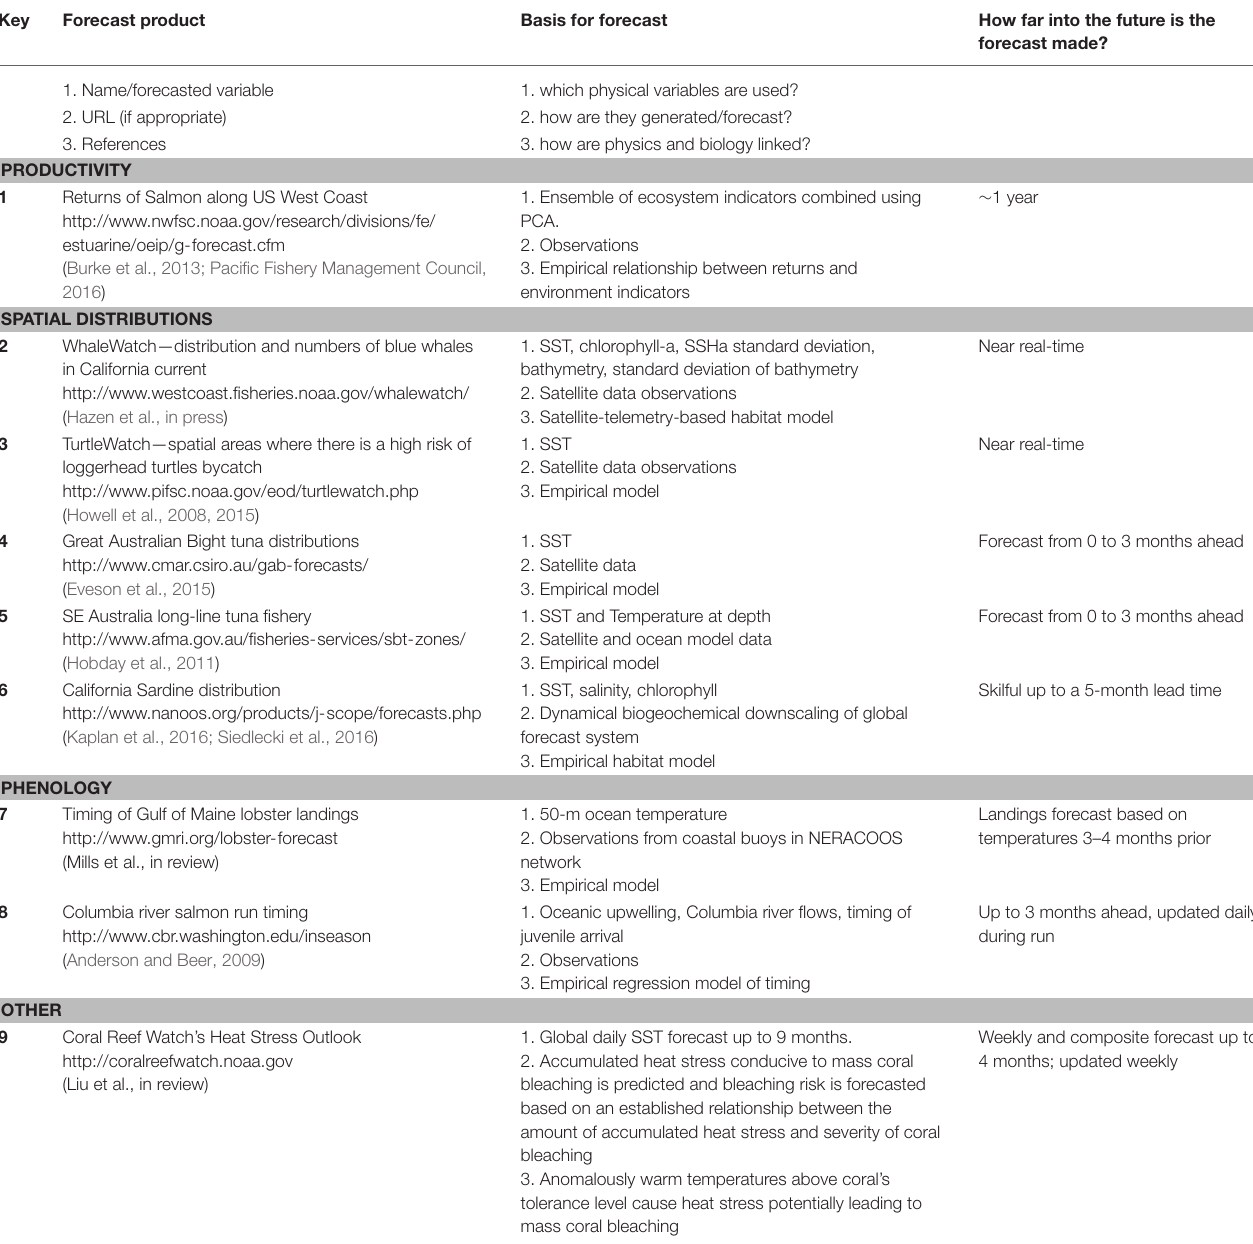
TABLE 1 | Overview of operational nowcast and forecast ecological products for application in the management of living marine resources found by the authors. Key Forecast product Basis for forecast How far into the future is the